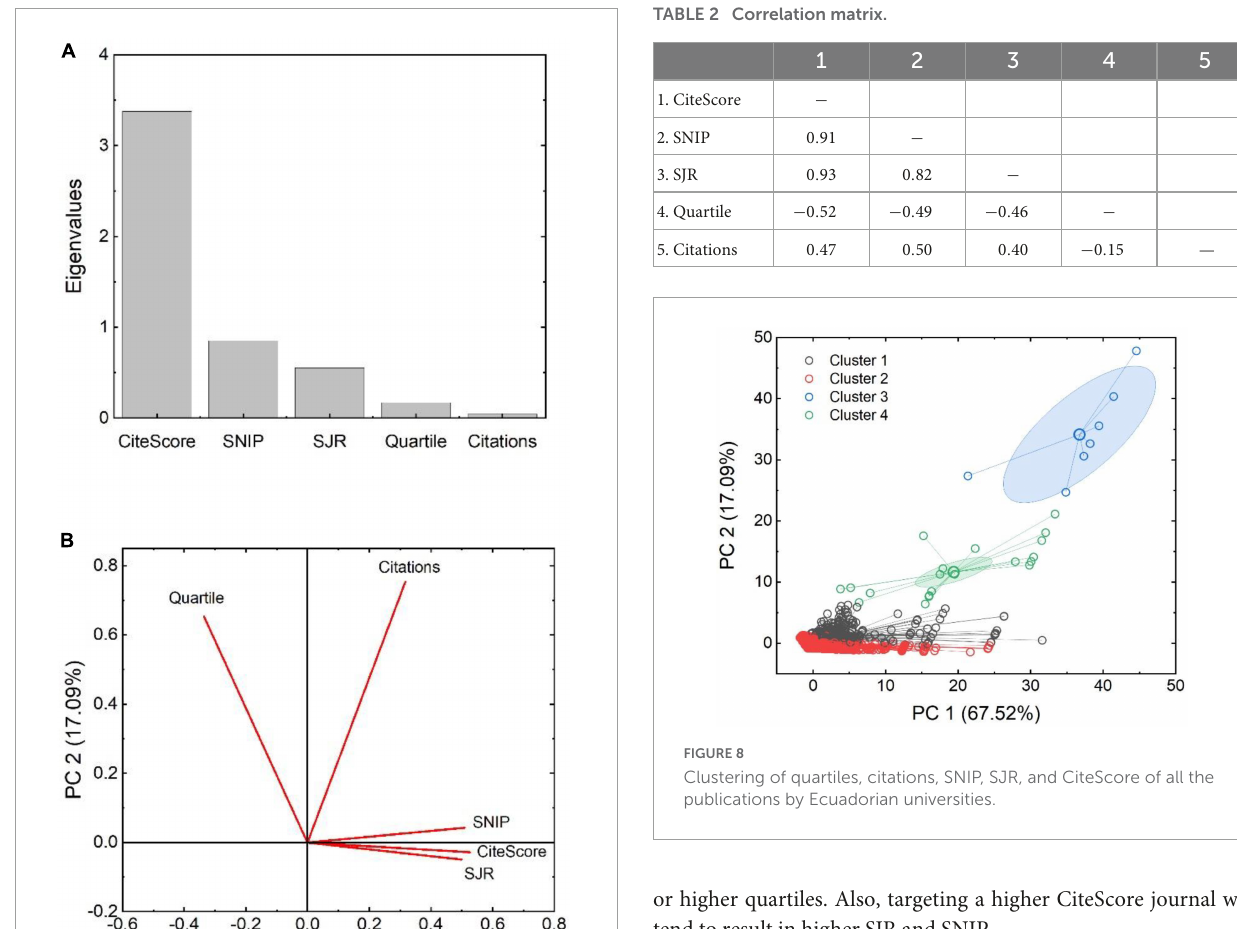
or higher quartiles. Also, targeting a higher CiteScore journal will tend to result in higher SJR and